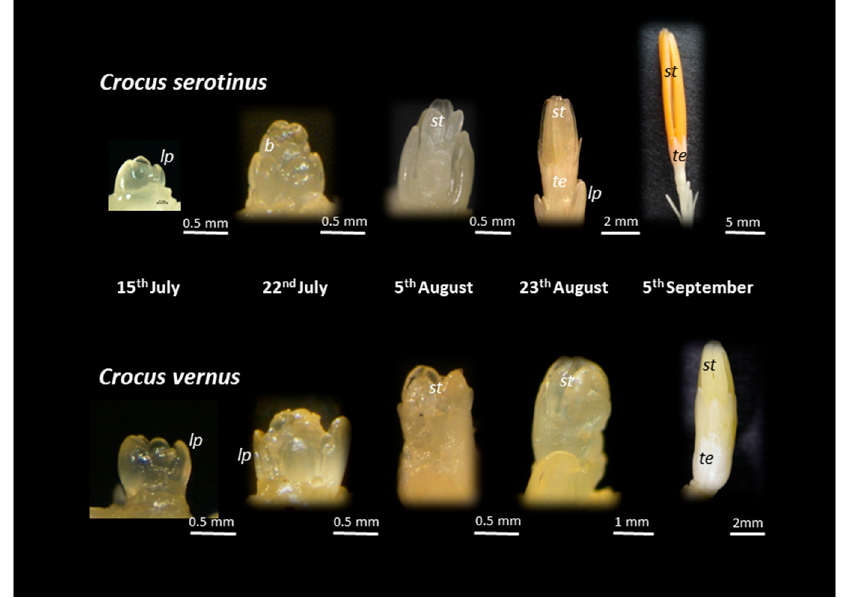
Figure 5. Microphotographs of flower differentiation in the autumn-flowering C. serotinus and spring-flowering C. vernus . After harvest, corms were stored at 23 °C until mid-September. On each date, at least 80% of the corms presented flower buds as shown in the figure. lp: leaf primordia; b: bract; st: stamen; te: tepal.